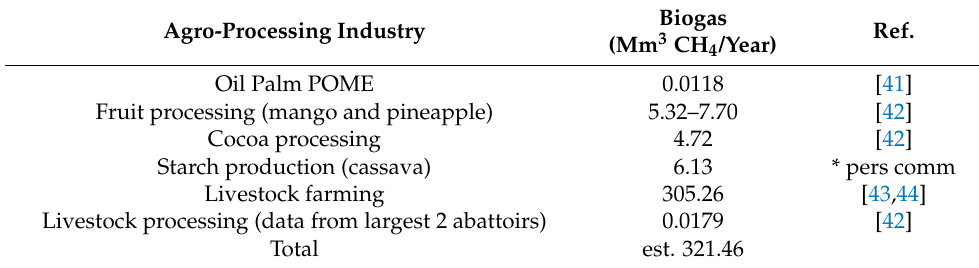
Table 2. Theoretical biogas potentials from agro-processing in Ghana. Agro-Processing Industry